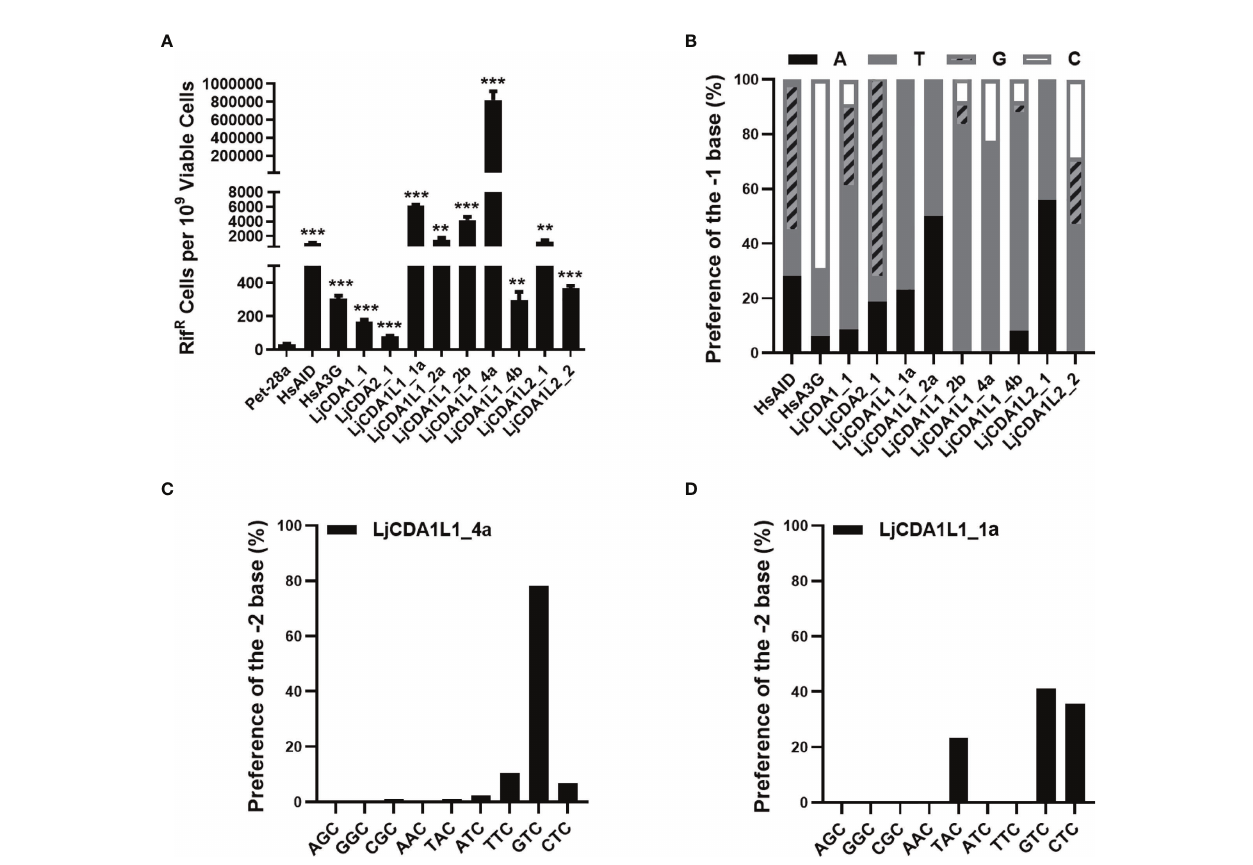
FIGURE 3 | LjAID/APOBEC stimulated rpoB mutations in Escherichia coli. (A) Mutagenic activities of the LjAID/APOBEC proteins in BL21 ung − / − E . coli . Activity was measured by the number of rifampicin-resistant (Rif R ) colonies per 10 9 viable cells (number of kanamycin-resistant colonies). Deaminase activities were evaluated against the vector control using an unpaired Student ’ s t -test with Welch ’ s correction. ***P < 0.0001, **P < 0.001. (B) The statistical analysis of the base preference of LjAID/APOBEC family proteins at the − 1 position upstream of cytidine deamination site (0). (C, D) The preferred trinucleotide of LjCDA1L1_4a and LjCDA1L1_1a on the rpoB gene in BL21 ung − / − E. coli